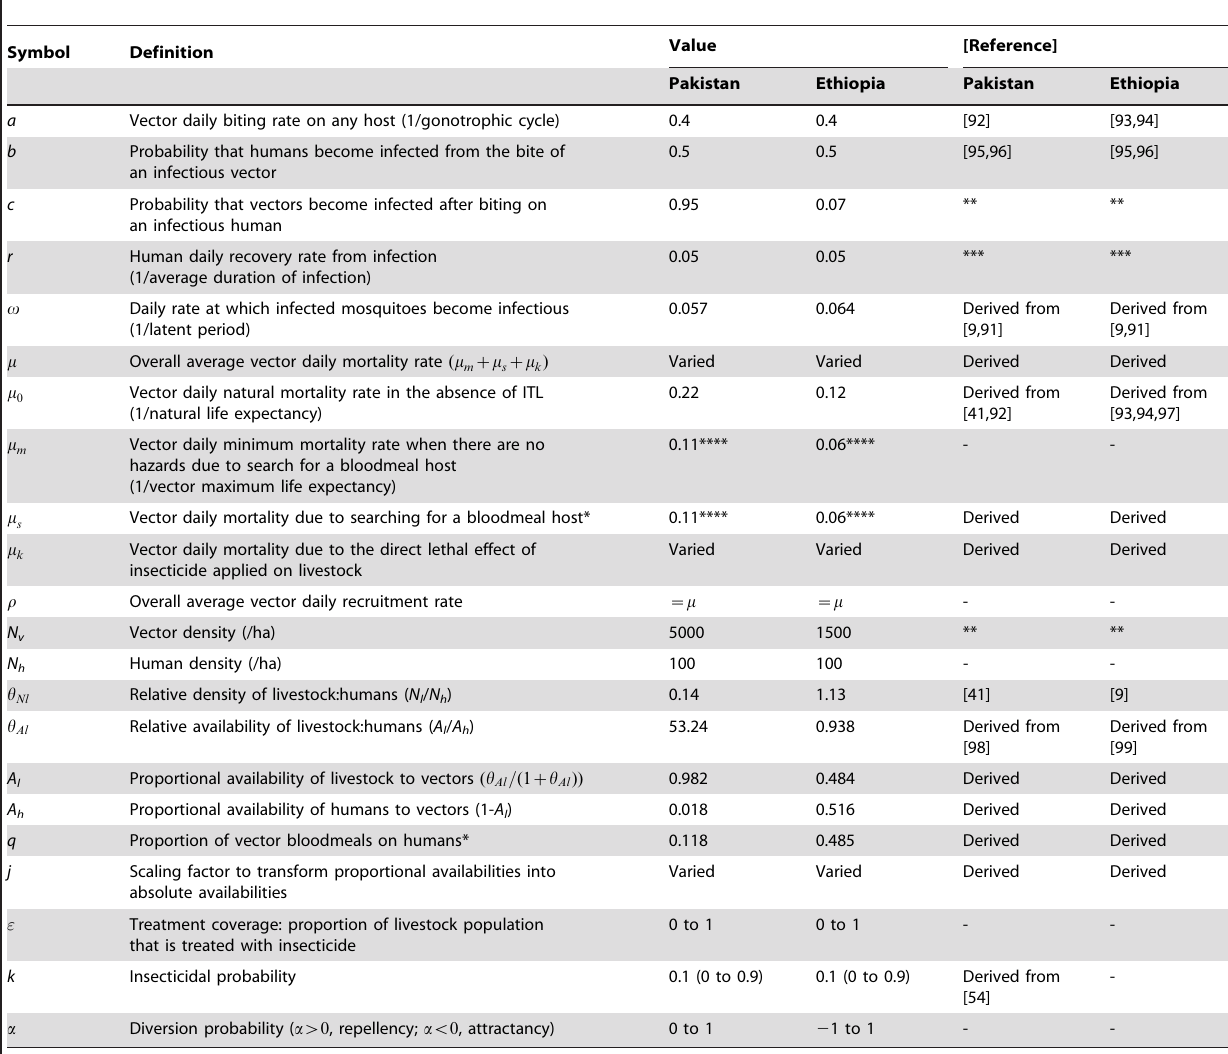
Table 2. Parameter values for modelling the effects of insecticide-treated livestock on malaria.